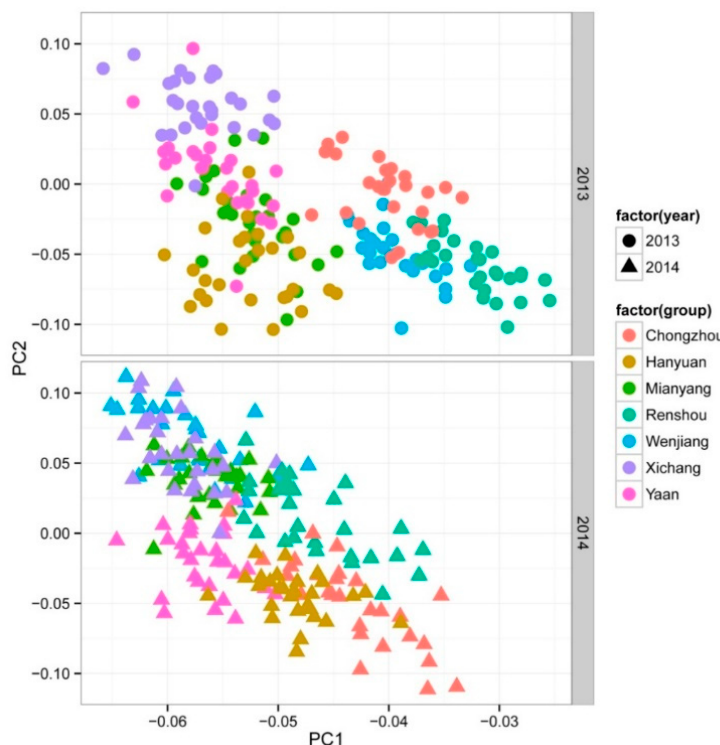
Figure 1. Principal component (PC) biplot based on the correlation matrix showing genetic correlation among characteristics of wheat across environments.